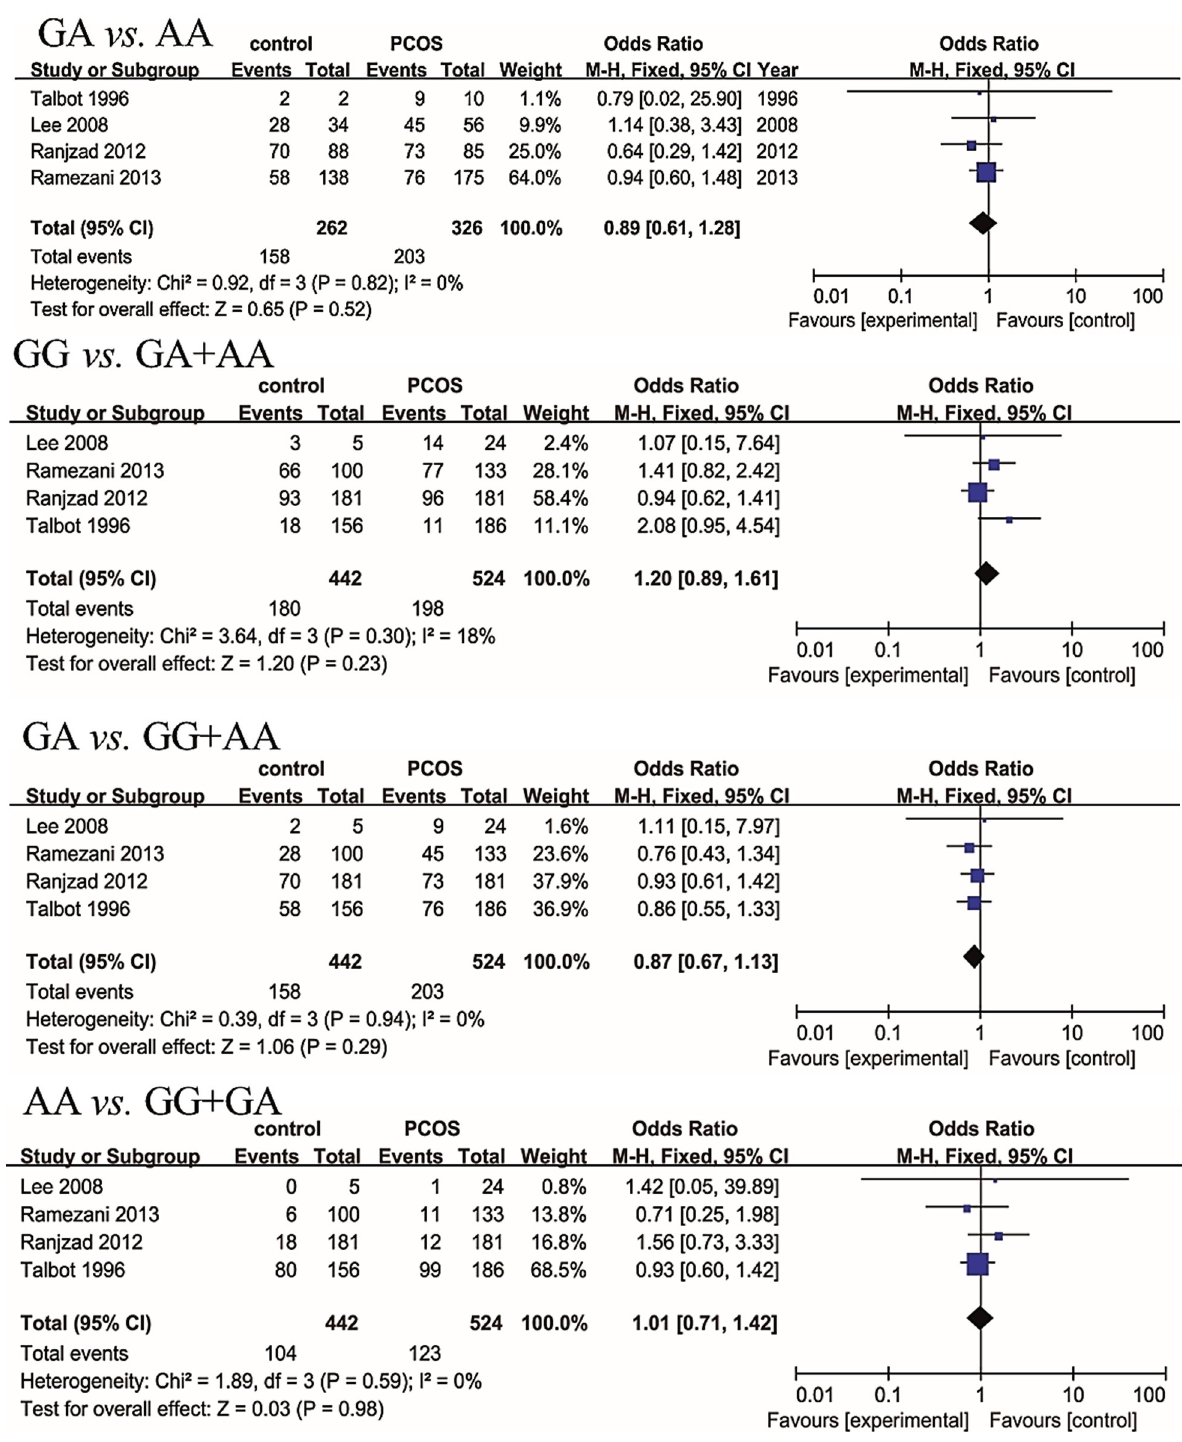
Figure 5. Forest plots of association between genotype frequencies of SNP rs2059806 and PCOS